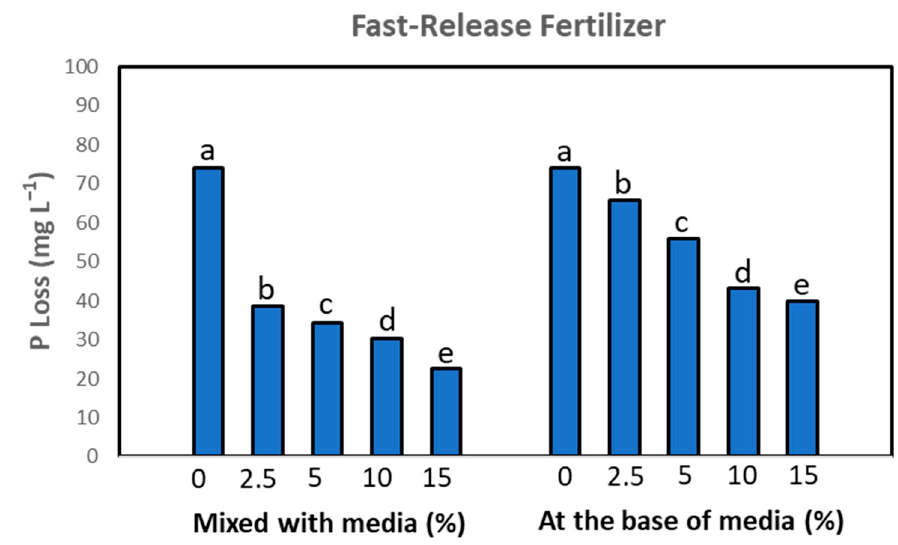
Figure 2. Mean dissolved reactive phosphorus (DRP) concentration loss in leachate as affected by FGD gypsum mixed with media or placed at the bottom of containers fertilized with a fast-release fertilizer. Within each gypsum application method, bars with the same letter are not significantly different ( p < 0.05).